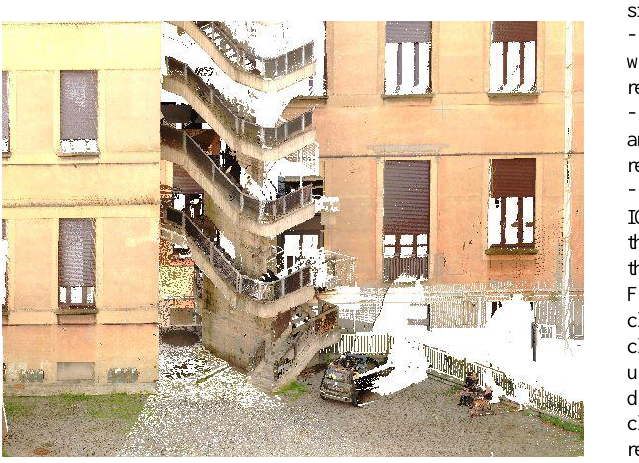
Figure 5 . TLS scans of the test area composing the dataset (c).